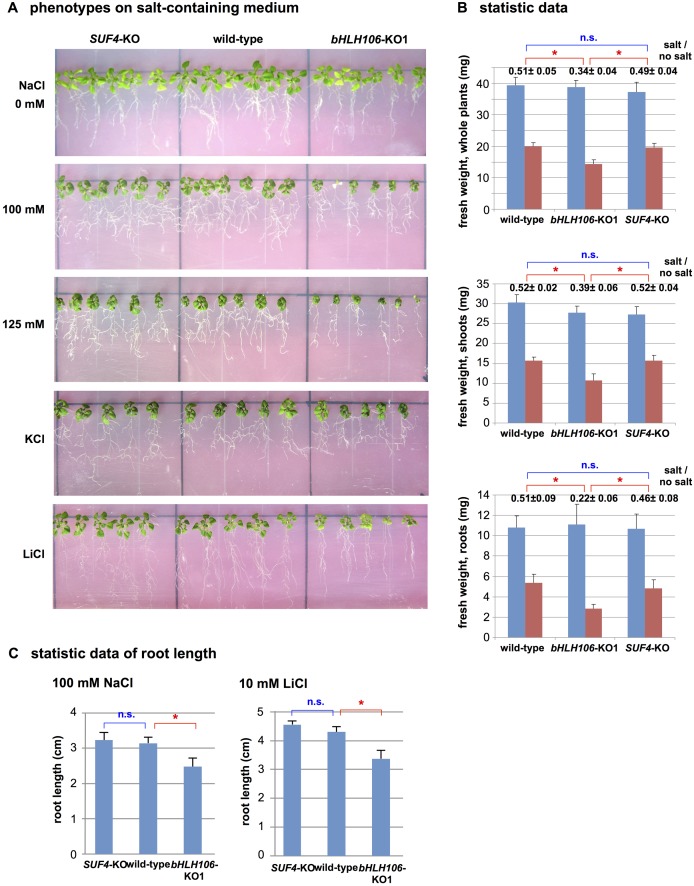
Phenotypes of bHLH106-KO line growing on culture medium containing NaCl, KCl, or LiCl.(A) bHLH106-KO1 and control plants were germinated and grown on standard MS medium for 4 days, and then transferred to media containing different concentrations of NaCl, 110 mM KCl, or 10 mM LiCl. Plants were then kept vertical in rectangular culture plates for 2 weeks. SUF4-KO is a KO line of SUF4 (At1g30970) for suppressor of FRI4 as an unrelated gene, and was used as a control for KO lines generated by T-DNA at the other loci. (B) Statistic data of plant growth with (red column) or without (blue column) NaCl in the same experiments shown in panel A. Fresh weights of whole plants were measured with or without 125 mM NaCl. Fresh weights of shoots and roots were measured with or without 100 mM NaCl. Error bars represent ±SEM from six experimental replicates. The numbers above columns are ratios of fresh weight of each line with salt to that without salt. Here are “n.s.” for no significant difference and * for P < 0.05 in ANOVA of the ratios. (C) Statistic data of root length in the same experiments shown in panel A. Here are “n.s.” for no significant difference and * for P < 0.05 in ANOVA.